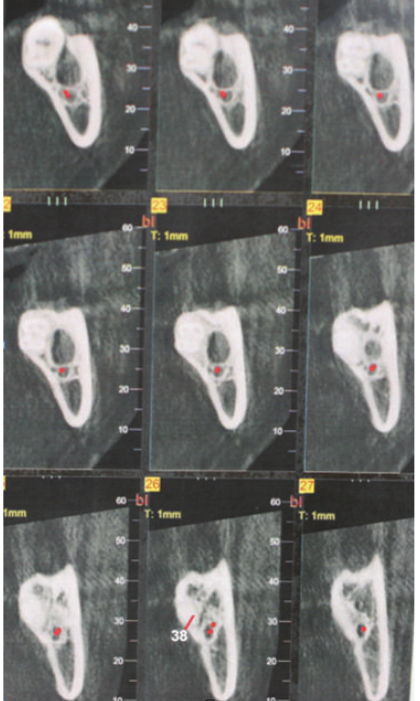
Figure 3: Preoperative tomography.